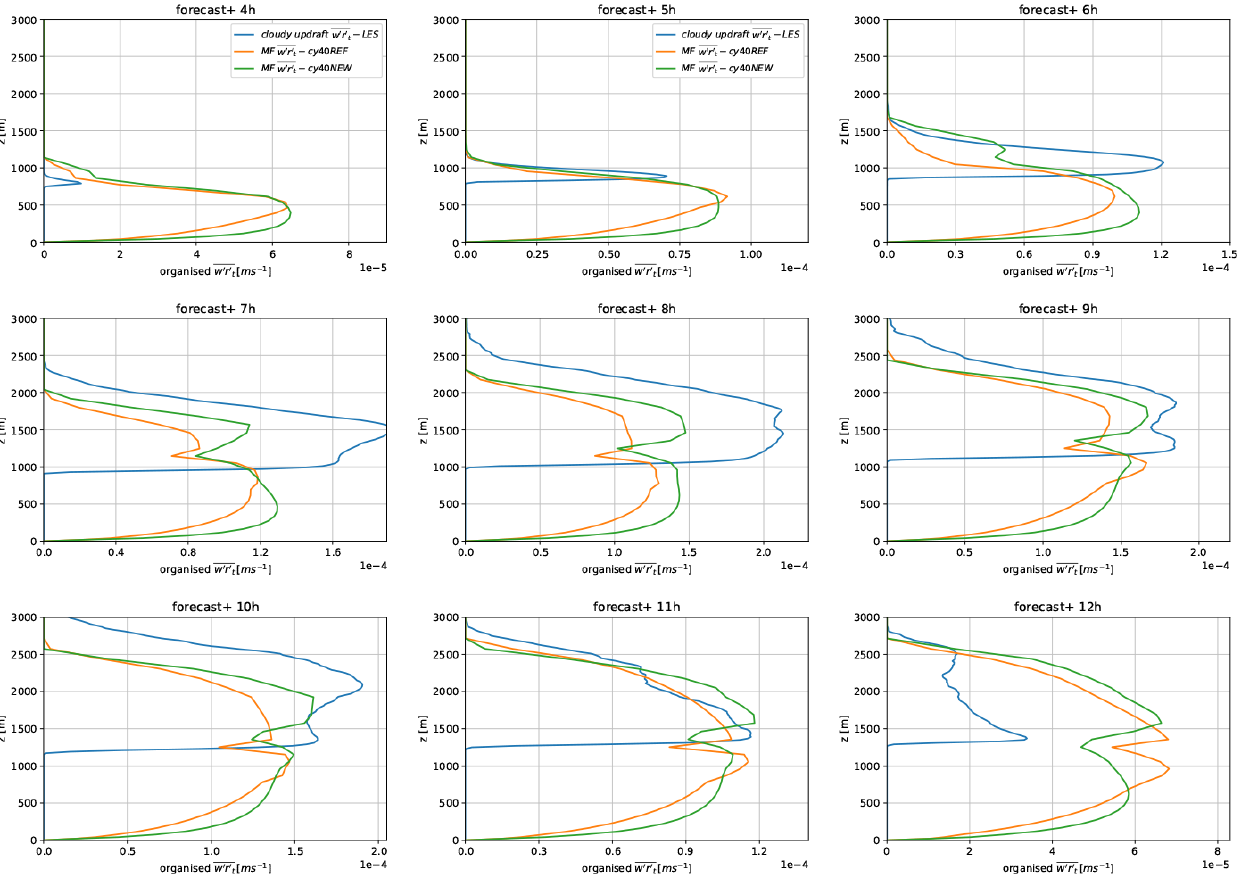
Figure B1. Kinematic convective transport (ms − 1 ) during all convective hours of the ARM case, corresponding to simulation hours + 4 to + 12h. Plotted is the mass flux (MF) transport by the convection scheme (orange indicates cy40REF and green is cy40NEW) and the estimated (cloudy updraft sampling) convective transport by the LES (blue). Note that the x -axis scale is not constant and equal to the scale of the corresponding plots in Fig.